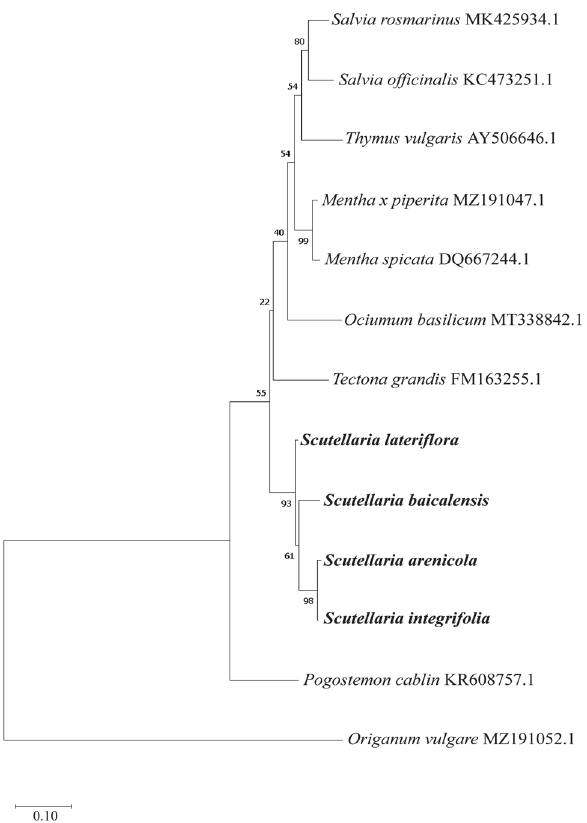
Figure 3. Phylogenetic analysis of selected Lamiaceae members using the ITS gene. A maximum-likelihood phylogenetic tree derived from multiple sequence alignments using the nuclear internal transcribed spacer ( ITS ) sequences of Scutellaria species with other Lamiaceae family members was constructed using MEGAv11.0 by maximum-likelihood (ML) method. Accessions in bold represent accessions sequenced for the current study. Origanum vulgare is included as an outgroup. Bootstrap values are from 1000 replicates, indicated above the nodes.